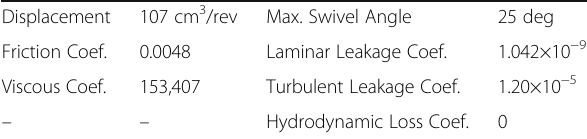
Table 2 Hydraulic motor parameters [17]